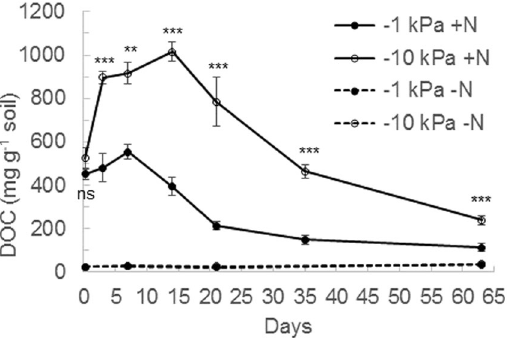
Figure 3. Changes in soil cold water extractable organic carbon (DOC) over time. Concentrations of soil DOC under near saturated ( − 1 kPa) or field capacity ( − 10 kPa) soil moisture conditions, following urea application ( + N) or nil urea application ( − N). Symbols are means (n = 4) with vertical error bars the standard error of the mean. Asterisks * , ** , *** indicate significant differences between moisture treatments under urea treatments at P < 0.05, P < 0.01, and P < 0.001,